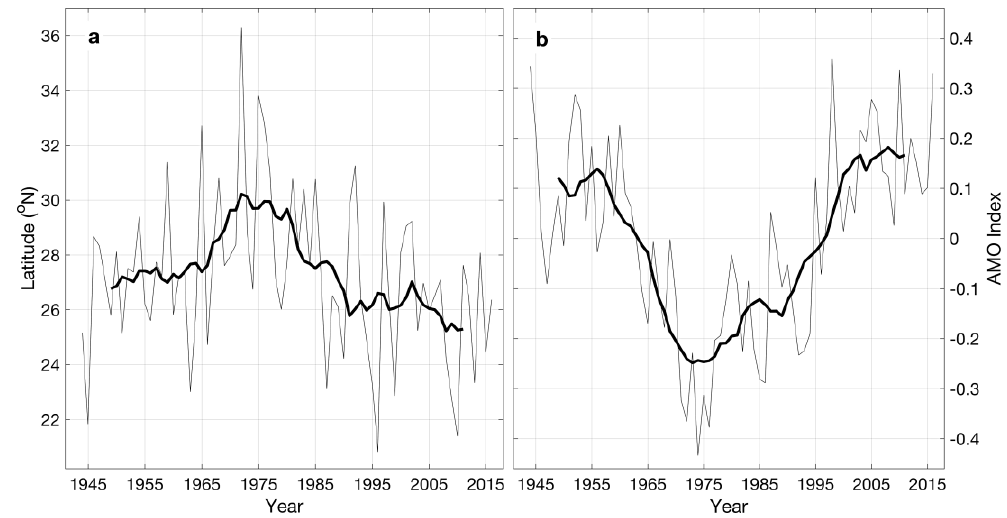
Figure 3. The relationship between the latitude of peak (lifetime-maximum) Atlantic tropical cyclone intensity and the Atlantic Multi-decadal Oscillation (AMO) index. Time series of ( a ) annually-averaged latitude of lifetime-maximum intensity, and ( b ) the AMO index. The raw time series (thin gray lines) correlate with R = −0.54 ( p -value ~ 0). The smoothed time series (thick black lines) representing decadal variability correlate with R = −0.86. Cool (warm) AMO phase correlates with a poleward (equatorward) shift of peak intensity.